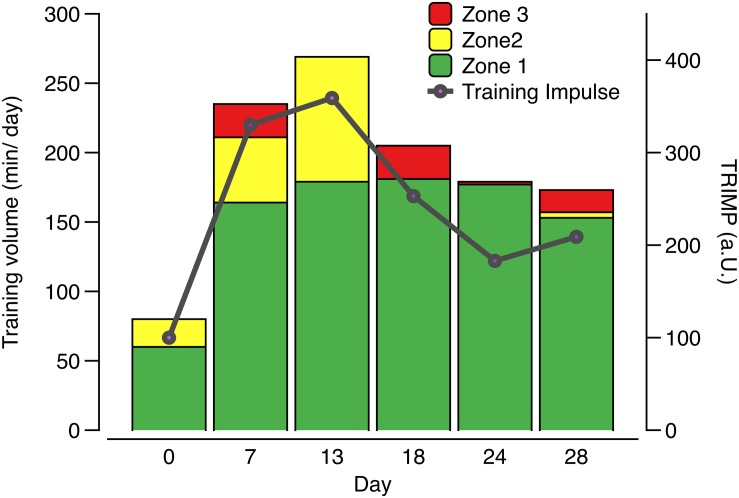
Average daily training volume, training intensity distribution, and resulting training load defined as TRIMP (intensity zone × duration) during 4 days prior to each testing time point in male junior world elite rowers during a 4-week pre-competition training camp before the junior world championships. Zone 1 refers to intensities of 50–70% of maximal heart rate, zone 2 to 70–80%, and zone 3 to 80–100%.